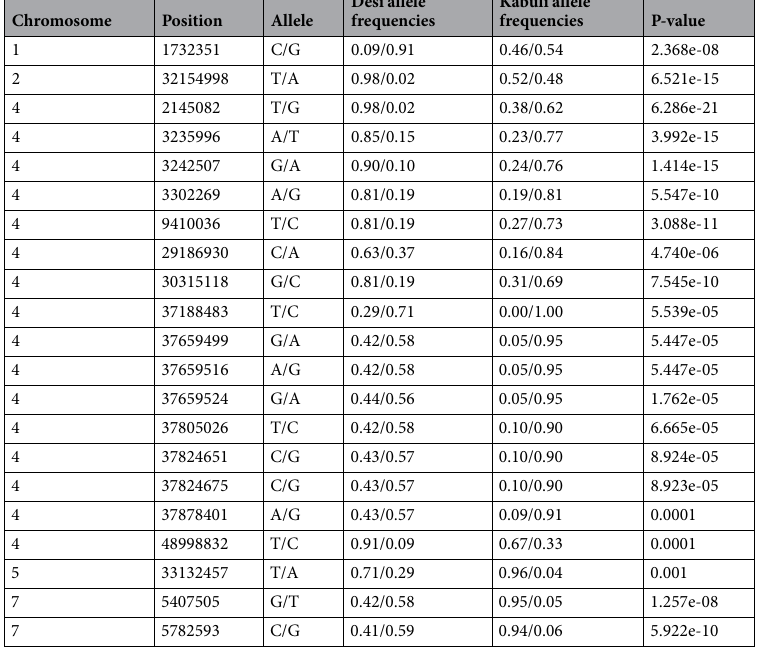
Table 1. Differences between Desi and Kabuli seed types in allele frequencies of GWAS SNPs. Chi-square test showed that 21 of 28 significant SNPs have significant associations (p-value < 0.05) with either Desi or Kabuli market class. Fisher’s exact test was used for alleles with less than 10